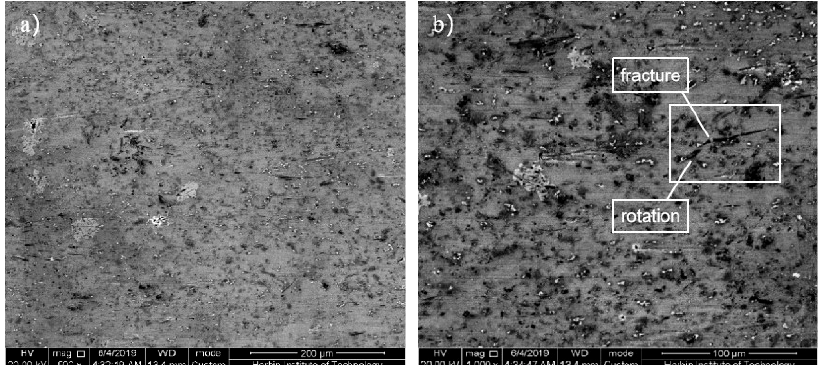
Figure 9. The SEM microstructure of samples after the first upsetting deformation: ( a ) 500 times; ( b ) 1000 times.